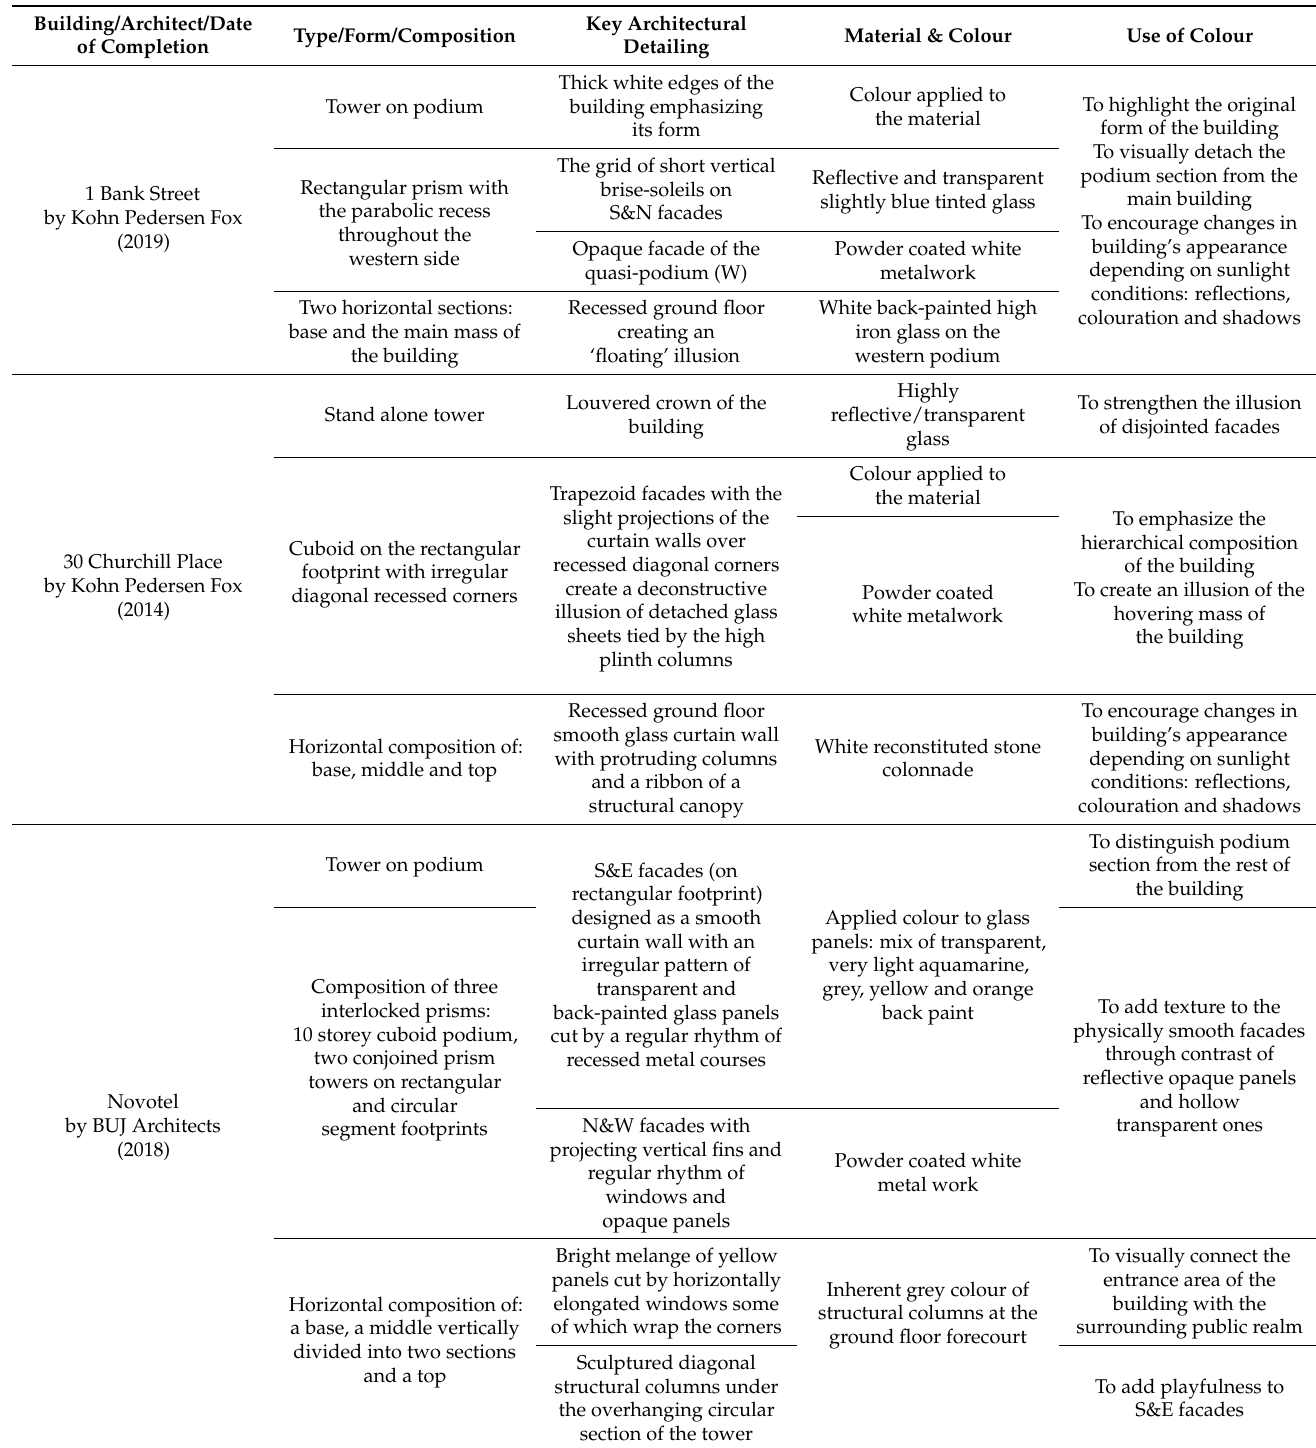
Table A3. Use of colour in tall non-residential buildings from the second phase of the regeneration on the Isle of